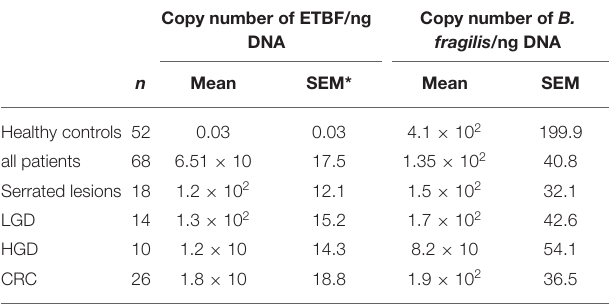
TABLE 4 | Quantitative analysis of the 16S rRNA gene and bft genes in clinicopathological groups and HC. Copy number of ETBF/ng